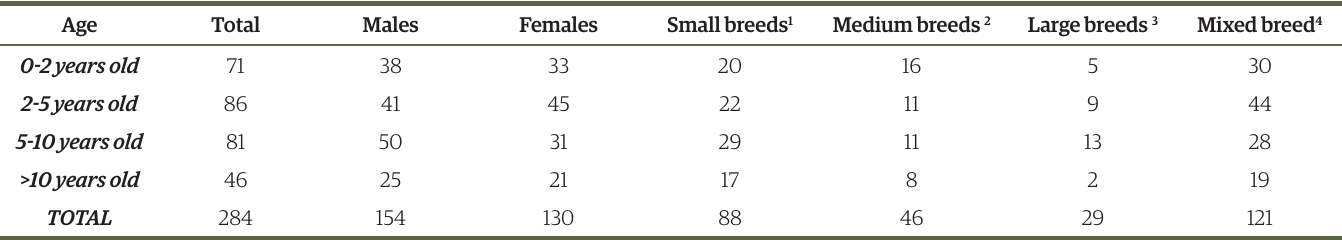
table 2. Characteristics of 284 dogs with neurological signs referred to the UFRRJ Veterinary Hospital, from August 2017 to April 2019. Seropédica, RJ.